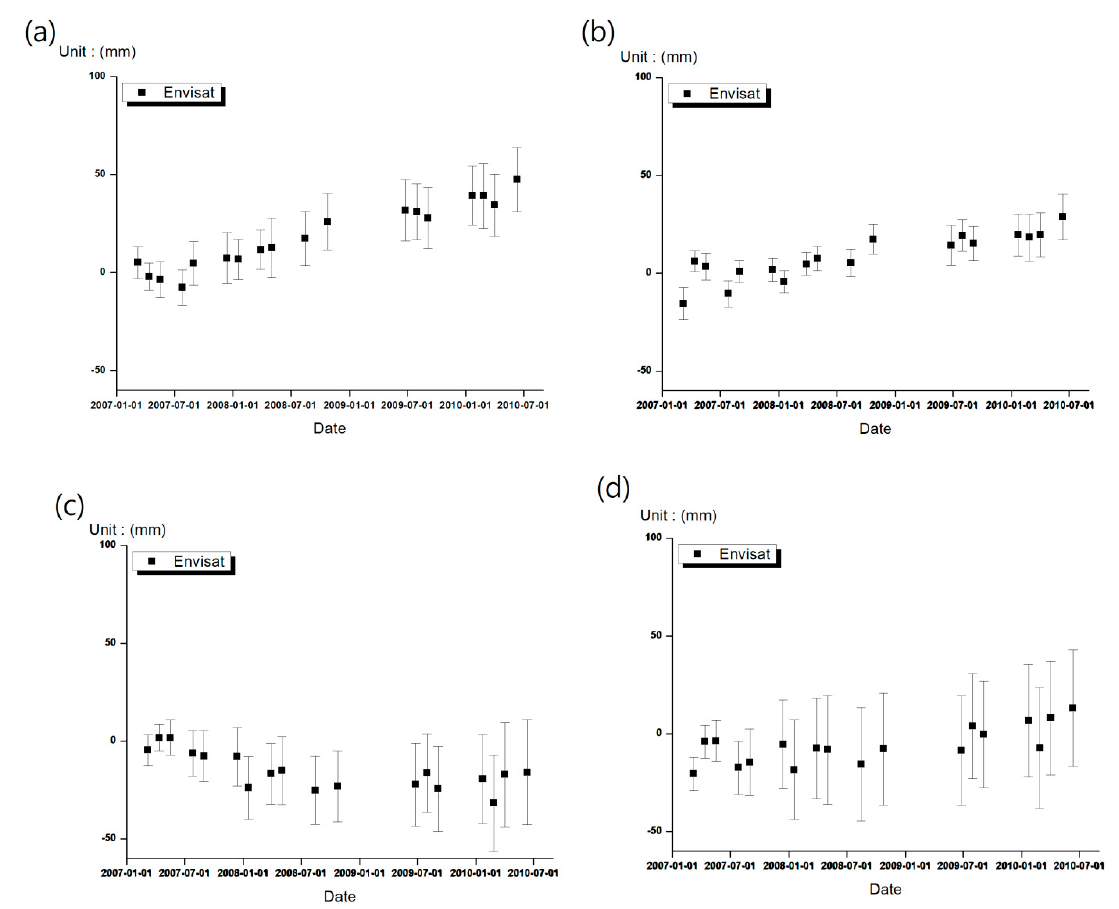
Figure 11. Cumulative deformation in obvious anomalous sites around the summit: ( a ) in site “a”, ( b ) in site “b”, ( c ) in site “c” and ( d ) in site “d” (see Figure 7 to identiy each location). Note that the error bar represents the standard deviation of deformation for each site. The error bar mean the standard deviation of surface deformation in each area 5.3. Geophysical Modelling and Interpretations